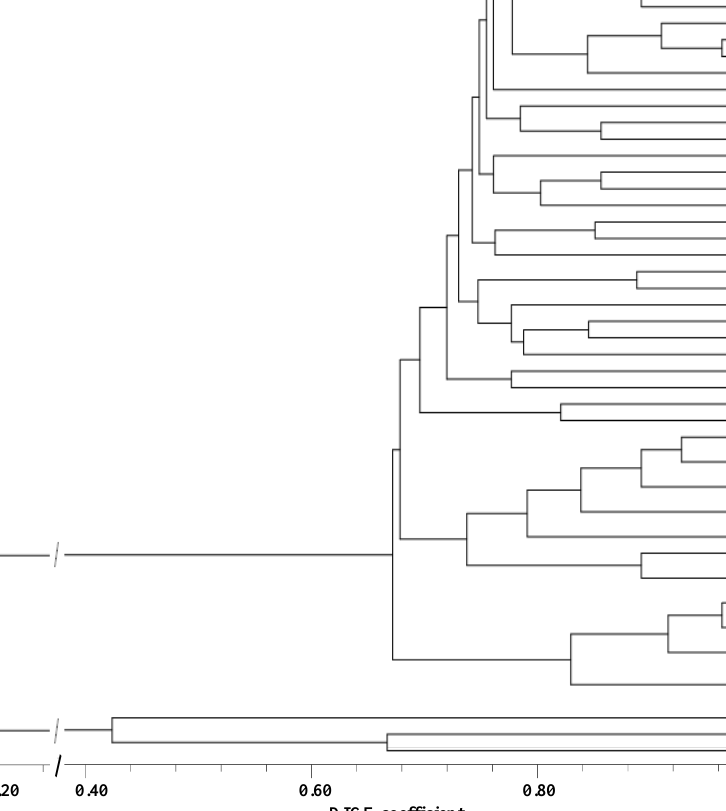
0 . 200 . 400 . 600 . 801 . 00